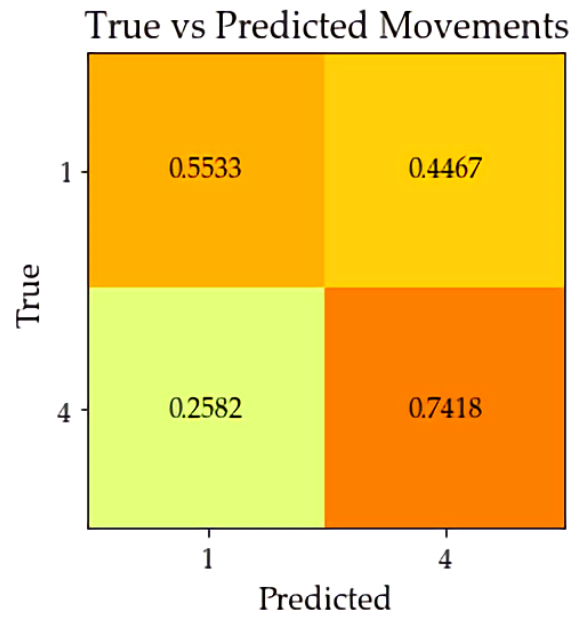
Figure 9. Results of real/generated samples on a trained